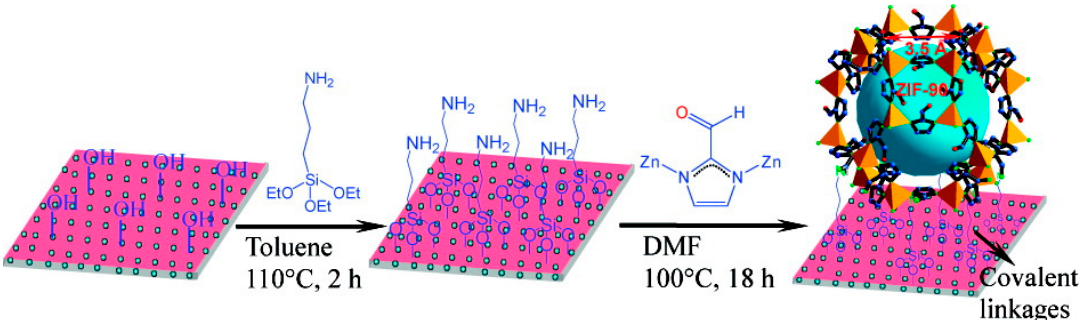
Figure 5. Schematic illustration of the preparation of a pure ZIF-67 membrane by the self-conversion of carbonate hydroxide nanowire arrays (Co-NWAs) (adapted with permission from ref. [81]).